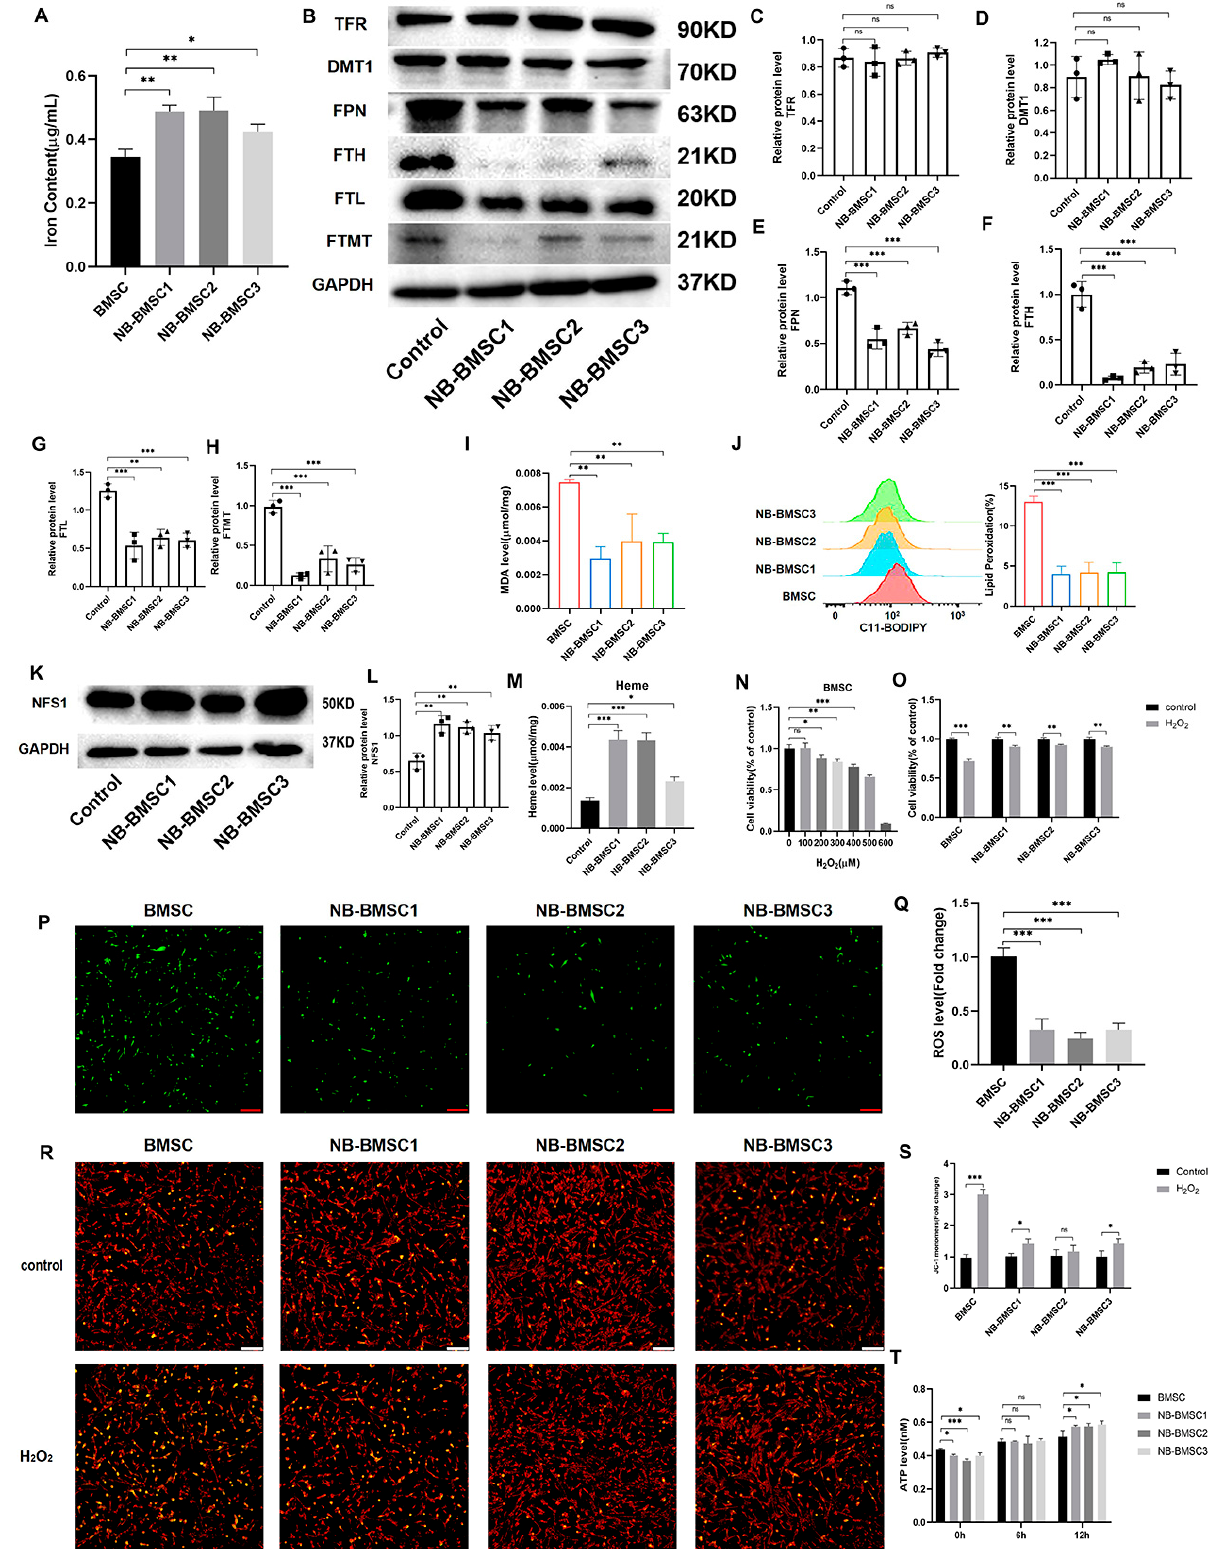
Figure 4. NB-BMSCs had smaller LIP. ( A ) Iron content of normal BMSCs and NB-BMSCs was detected. ( B – H ) Western blotting was used to analyze protein levels of TFR, DMT1, FPN, FTH, FTL, FTMT. ( I , J ) MDA level and lipid peroxidation level was used to reflect the ferroptosis level of nor- mal BMSCs and NB-BMSCs. ( K , L ) NFS1 level was detected by Western blotting. ( M ) A heme assay kit was used to detect the heme level of normal BMSCs and NB-BMSCs. ( N ) Cell viability of BMSCs were assessed after 0–600 μ M H 2 O 2 treatment, and ( O ) 400 μ M H 2 O 2 were used to assess the cell viability of normal BMSCs and NB-BMSCs. ( P , Q ) ROS level was detected in normal BMSCs and NB- BMSCs. Scale bar: 250 μ m. ( R , S ) JC-1 assay was performed to assess the changes in mitochondrial membrane potential. Scale bar: 250 μ m. ( T ) ATP level was used to reflect the metabolic status of